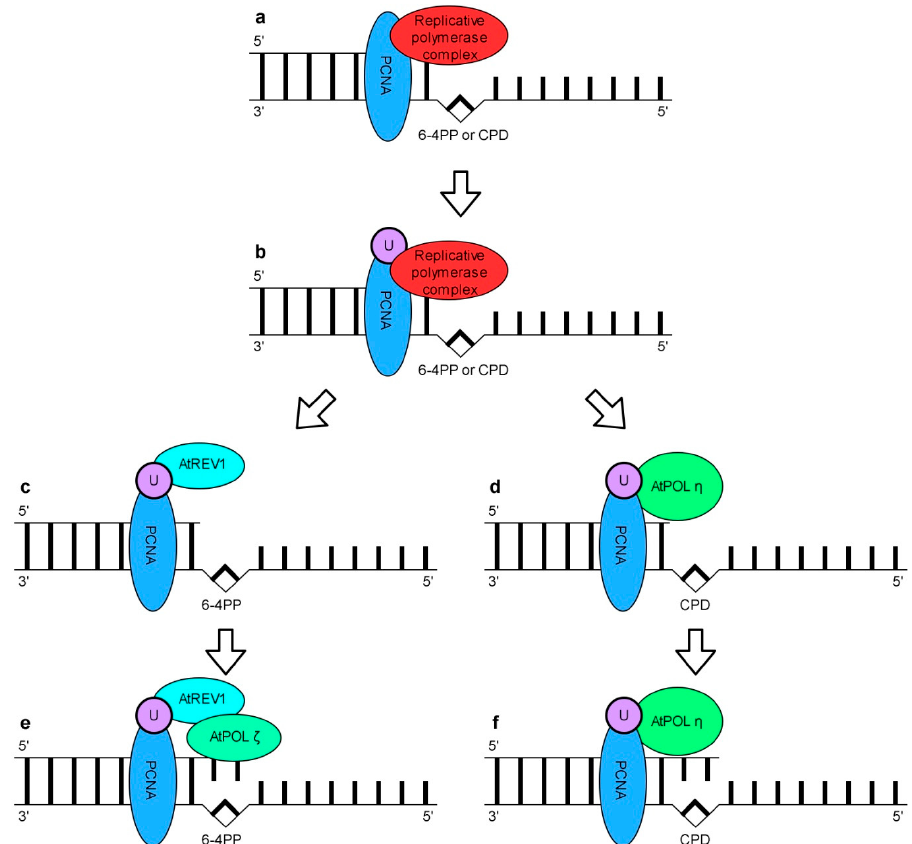
Figure 7. A schematic representation of a translesion synthesis (TLS) model in Arabidopsis. Replicative polymerase complex (either pol δ or pol ε ) are blocked by a CPD or 6-4 PP DNA lesion ( a ). PCNA is monoubiquitynated ( b ). TLS polymerase which has a strong a ffi nity to monoubiquitinated PCNA is recruited and replaces replicative polymerase complex. AtREV1 ( c ) and AtPOL η ( d ) are preferentially recruited to CTD and 6-4 PP, respectively. AtREV1 recruits another polymerase such as AtPOL ζ , which can add nucleotides regardless the lesion, but is error-prone ( e ). AtPOL η synthesis is error free ( f